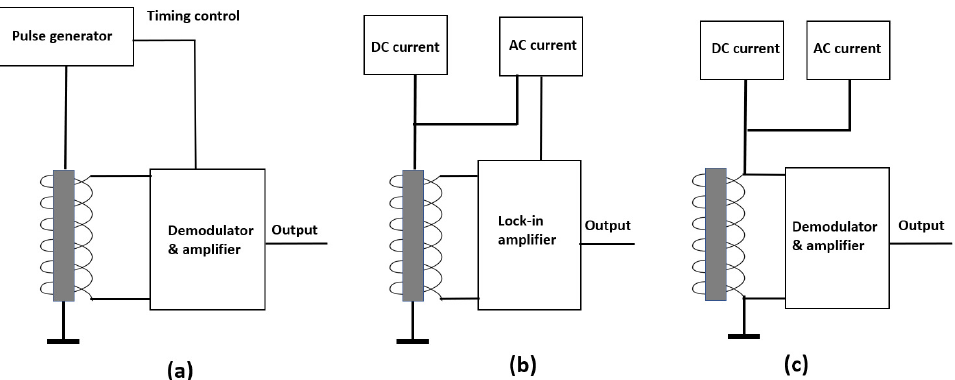
Figure 1. High-sensitivity magnetic sensors with Co-rich ferromagnetic amorphous wires ( a ). Block diagram of the GMI sensor ( b ). Block diagram of the orthogonal fluxgate sensor ( c ). Block diagram of the parallel fluxgate sensor.